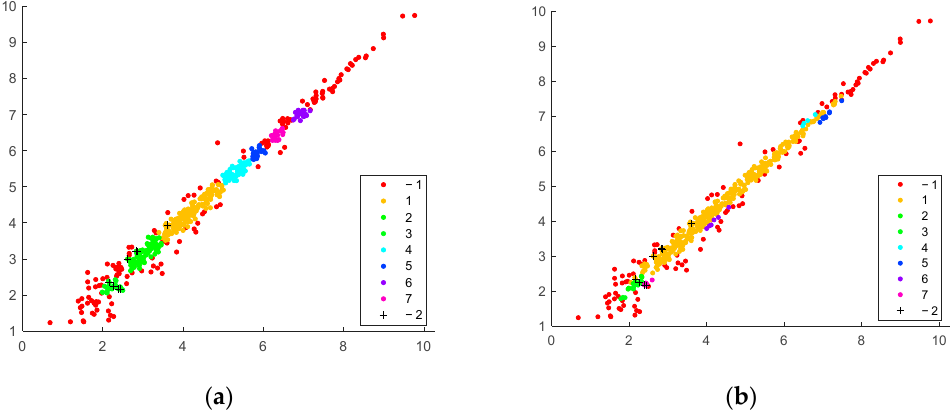
Figure 5. Clustering of the 7th batch and the batch of 511 genes; Tstd = 0.3. ( a ) Euclidean distance, 8 std genes. ( b ) Mahalonobis distance, 8 std genes.